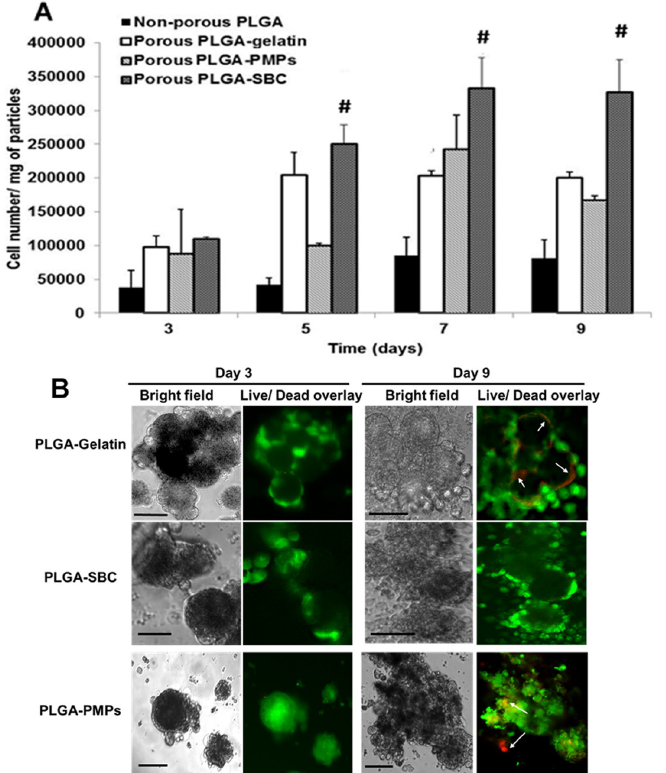
Fig 5. Cellular proliferation on porous MPs. (A) A549 cell proliferation on fibronectin-coated particles up to 9 days, showing significantly higher cell growth on PLGA-SBC porous particles compared to the non-porous control particles and other porous particles (PLGA-Gelatin, and PLGA-PMPs. The data plotted in terms of average ± standard error obtained from samples size (n) of 4 (# represents p < 0.05 w.r.t porous PLGA-Gelatin and PLGA-PMPs). (B) Live/Dead staining shows A549 lung cancer cells attached on porous PLGA MPs were viable for up to 9 days with minimal cell death. PLGA-PMPs and PLGA-Gelatin MPs showed cell death on day 9 (arrows); however, cells on PLGA-SBC MPs remained viable throughout the study (Scale = 10 μ